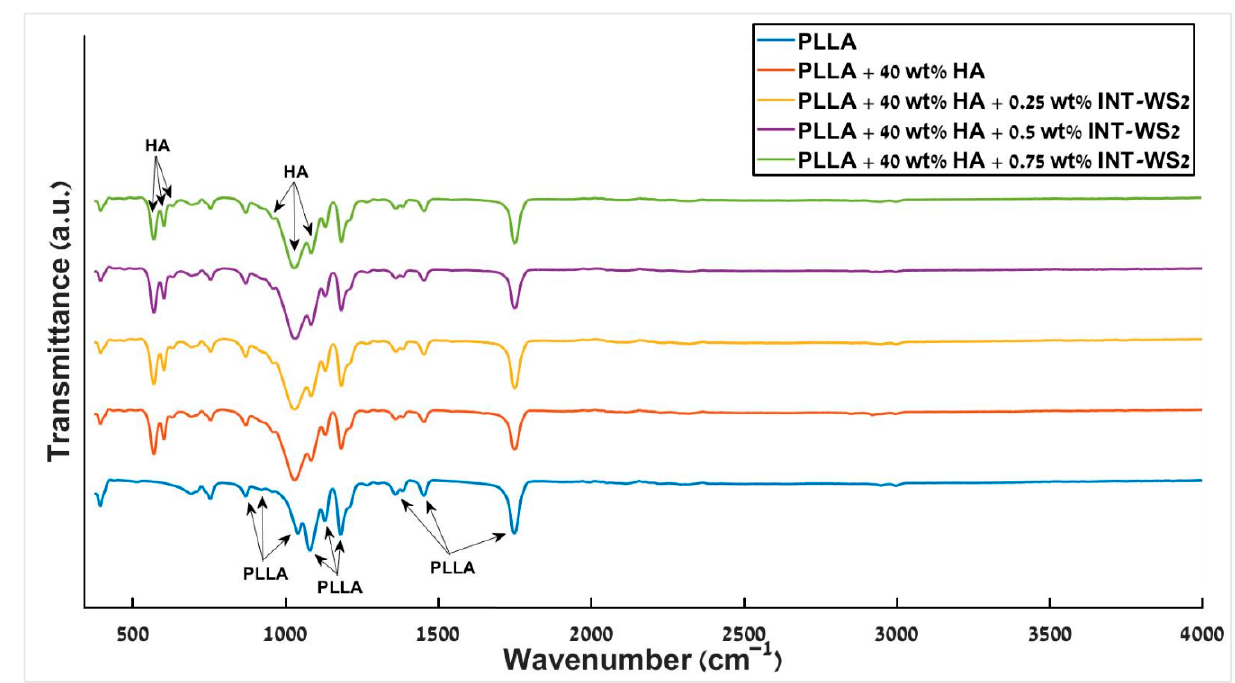
Figure 11. FTIR spectra of different PLLA/HA/INT-WS 2 nanocomposite films.